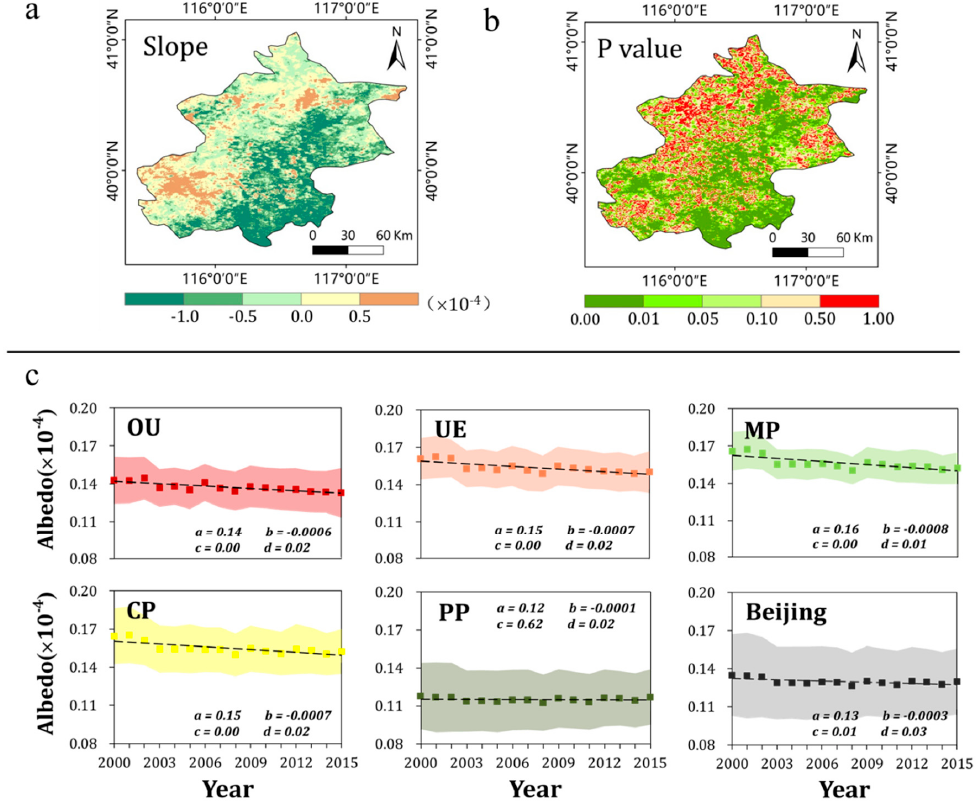
Figure 10. Spatial pattern and temporal changes of surface albedo in Beijing. a and b are the spatial patterns of the annual trend and significance test (P value); c is the annual changes with standard deviations (shadow zones with different colors) of various land cover types for surface albedo from 2000 to 2015.